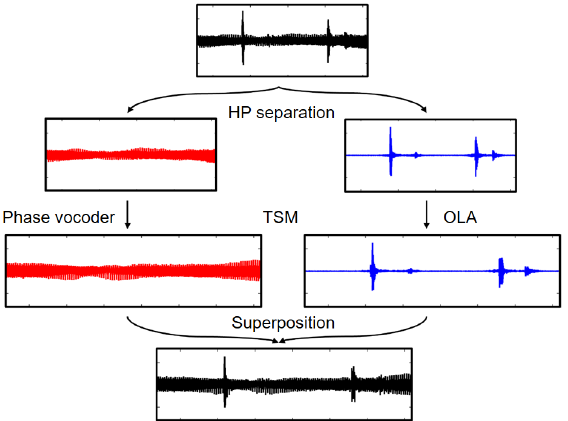
Figure 21. Application of HPS for time–scale modification (TSM), where TSM based on the phase vocoder is used for the harmonic component and TSM based on OLA (overlap-add techniques) is used for the percussive component (see [53]).